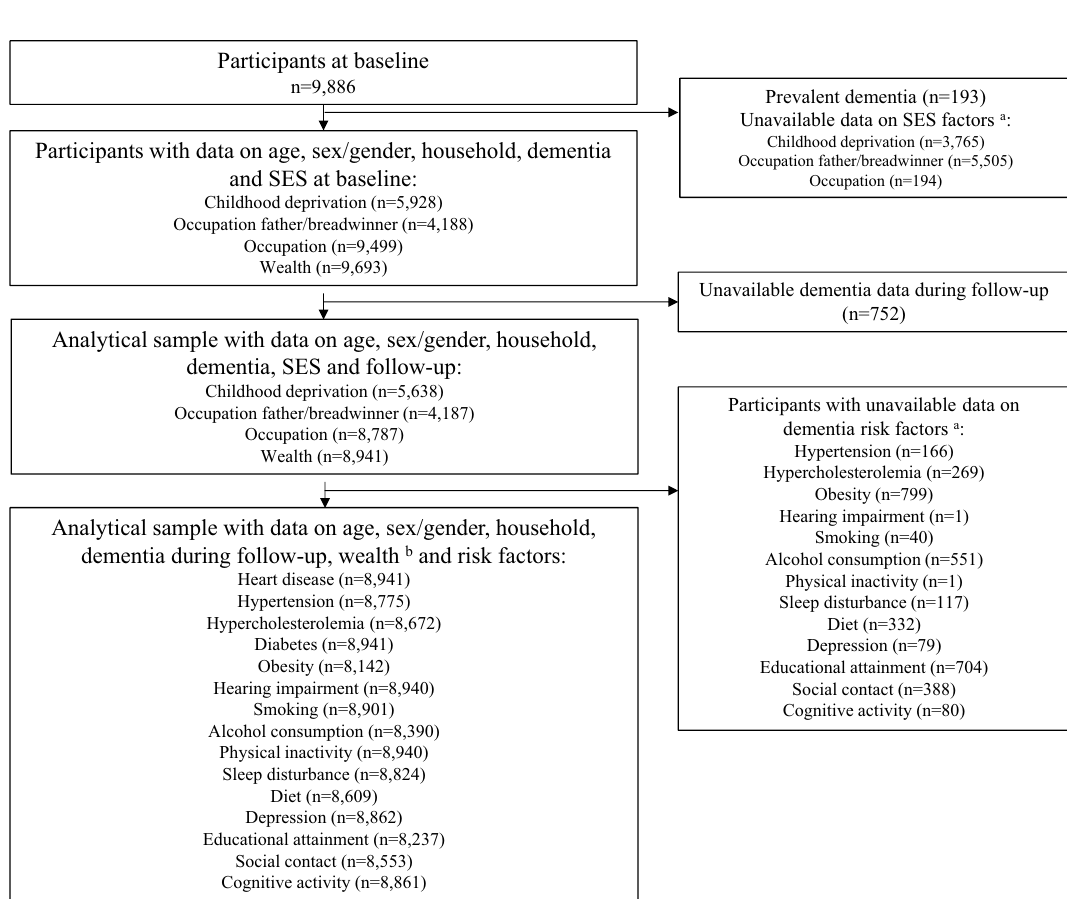
Figure 1. Flowchart. ( a ) Missing data are not mutually exclusive. ( b ) Data on childhood deprivation, occupation breadwinner and occupation are missing in respectively n = 3303, n = 4754, and n = 154